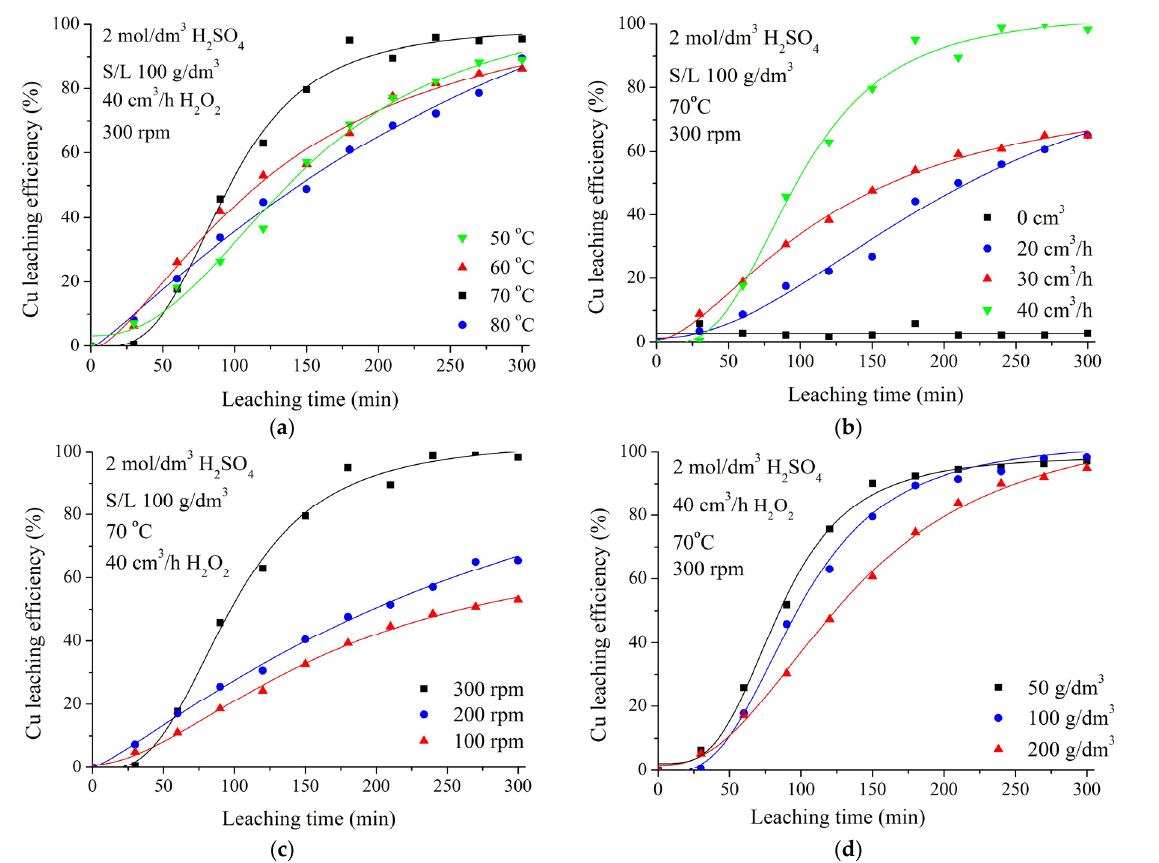
Figure 4. Influence of various process parameters on Cu leaching efficiency: ( a ) temperature; ( b ) H 2 O 2 addition; ( c ) stirring rate; ( d ) S/L ratio.